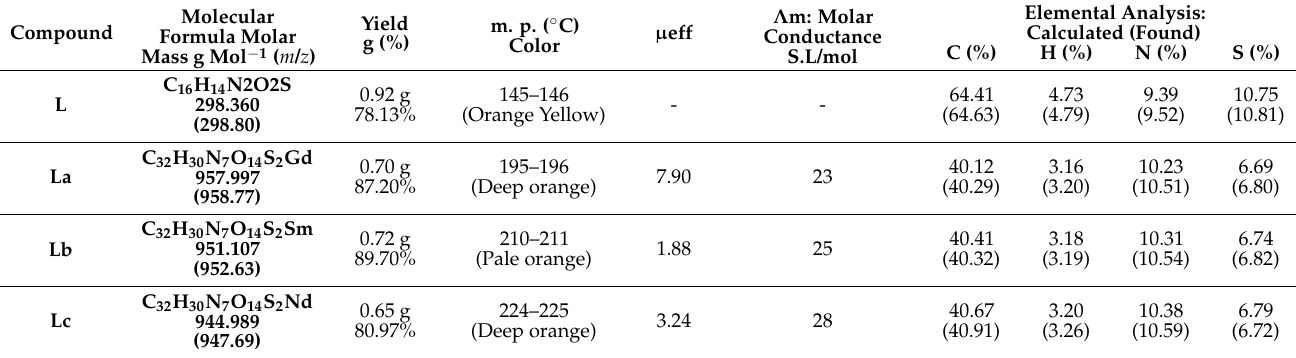
Table 2. Physicochemical properties of synthesized